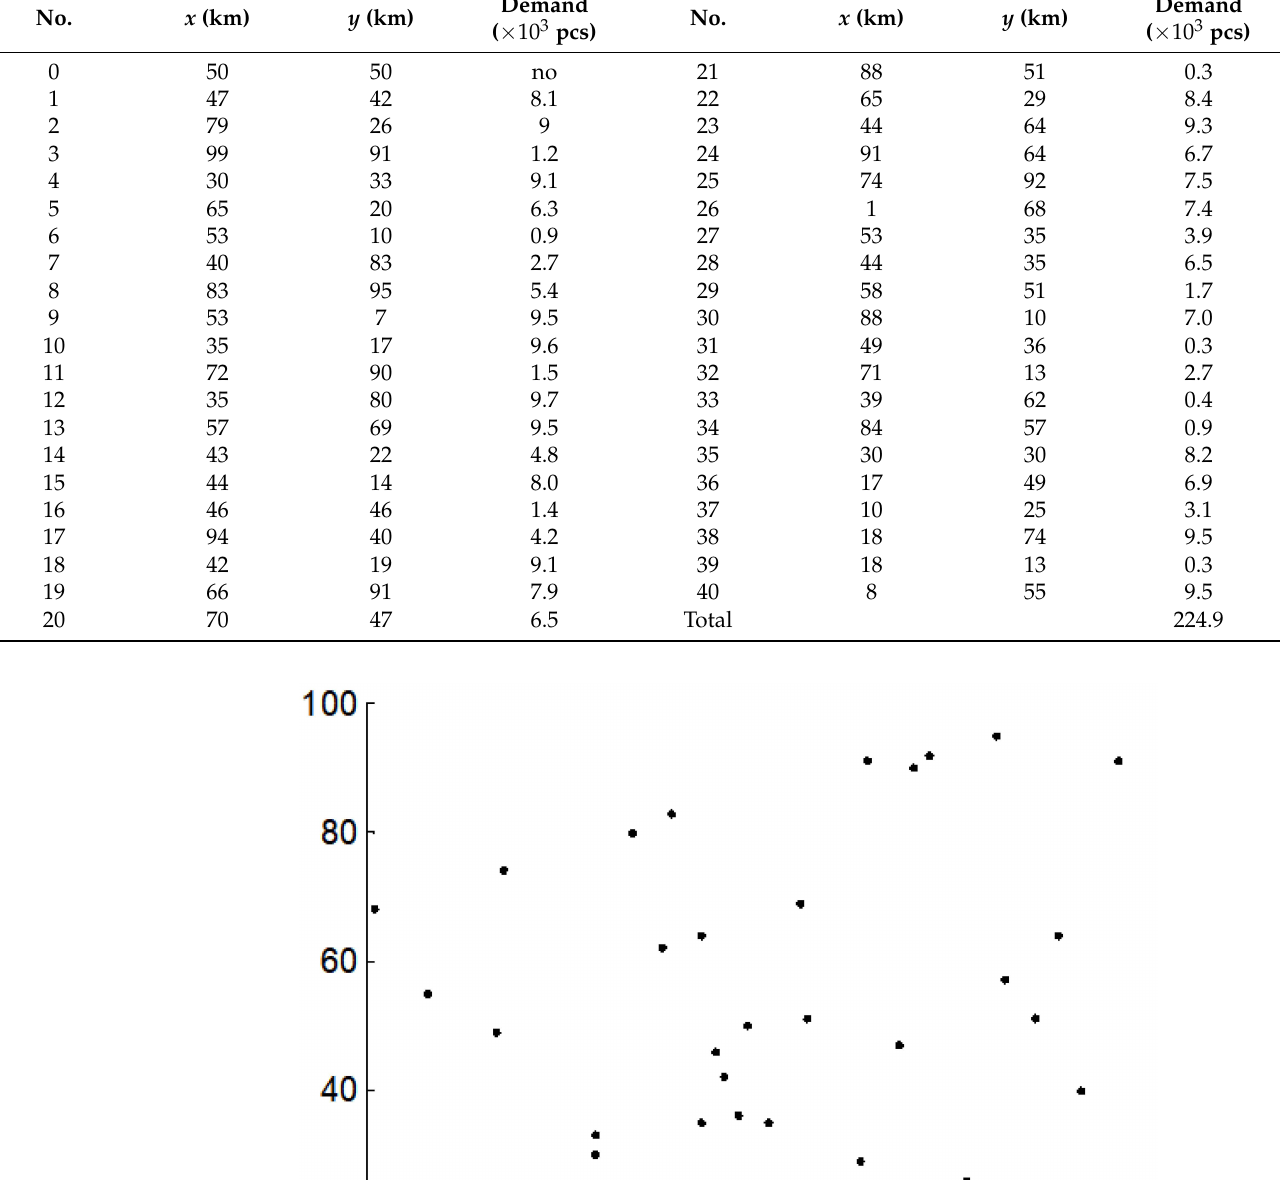
Table 1. The coordinates and demand quantities of the demand nodes.